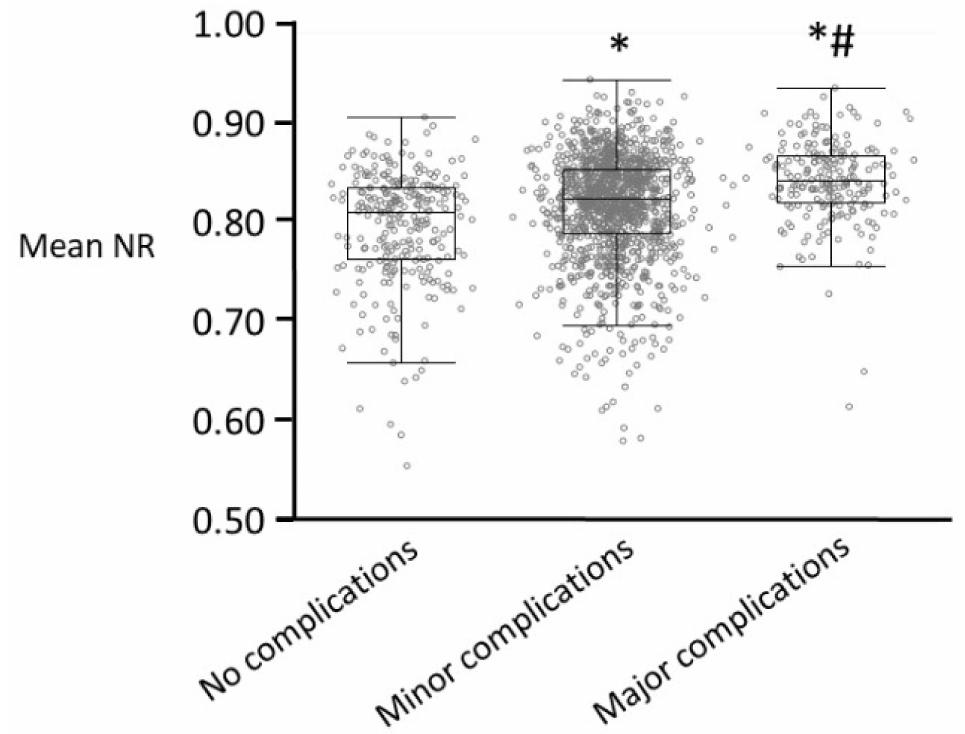
Figure 2. Box-and-whisker plots of averaged values of NR from the start to the end of surgery (mean NR) in patients with no complications (n = 263), minor complications (Clavien–Dindo classification = I or II, n = 1201), and major complications (Clavien–Dindo classification ≥ IIIa, n = 212) after surgery. Gray circles show individual data points. Data in this graph were obtained from [44–46,84,85]. Significant differences are defined at * p < 0.001 vs. no complications, and # p < 0.001 vs. minor complications. NR; nociceptive